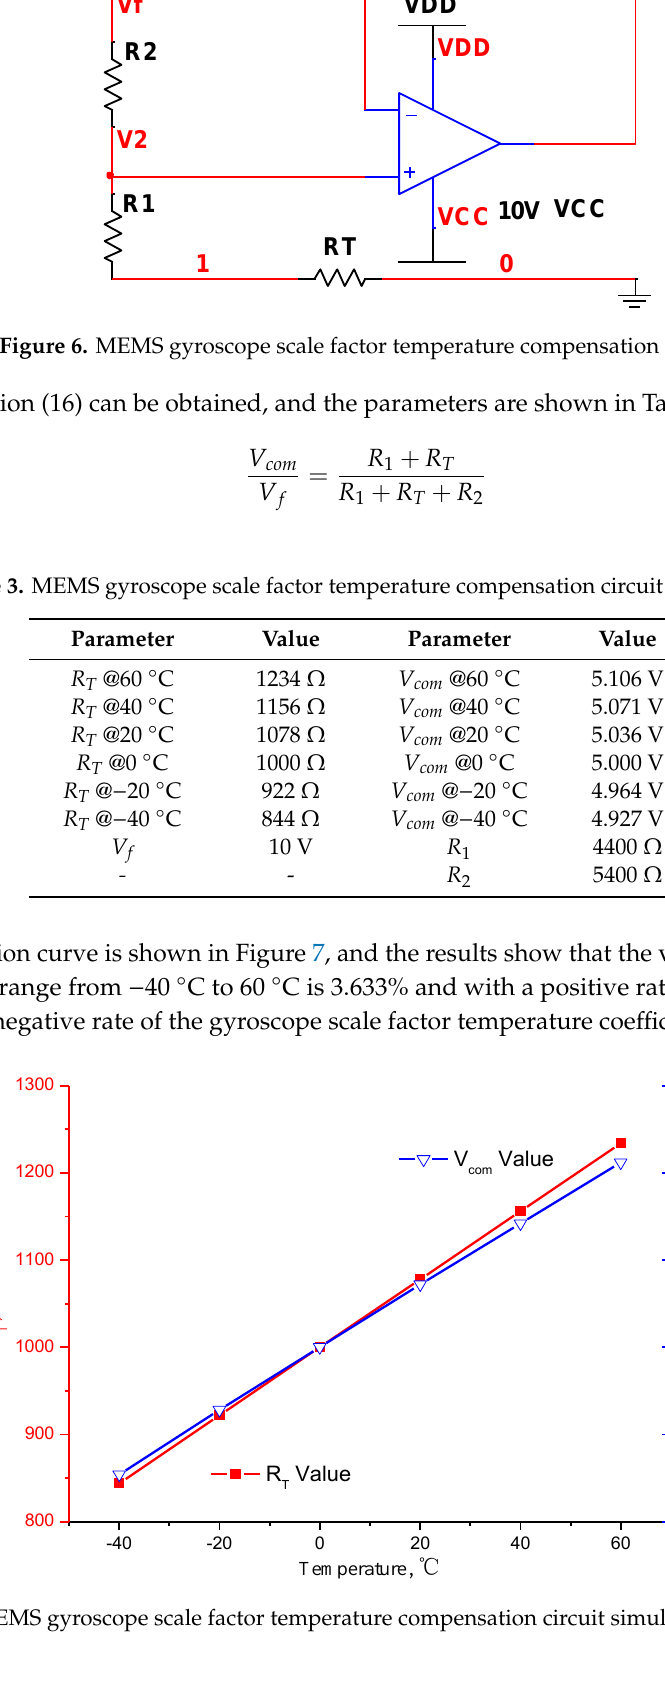
Figure 7. MEMS gyroscope sca le factor temperature compensation circuit simulation result curves.